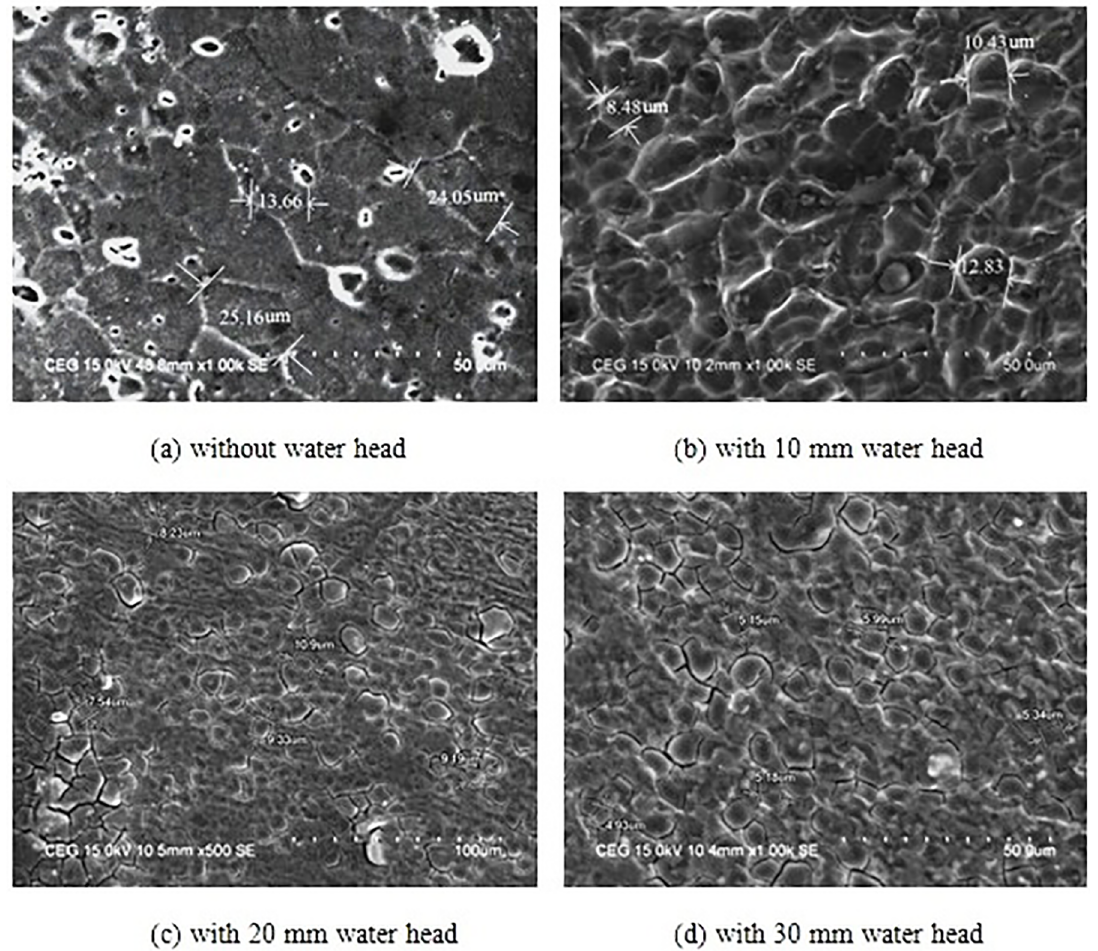
Figure 12 . Scanning electronmicrographs of the SZ (a) without water head (b) with 10 mm water head (c) with 20 mm water head (d) with 30 mm water